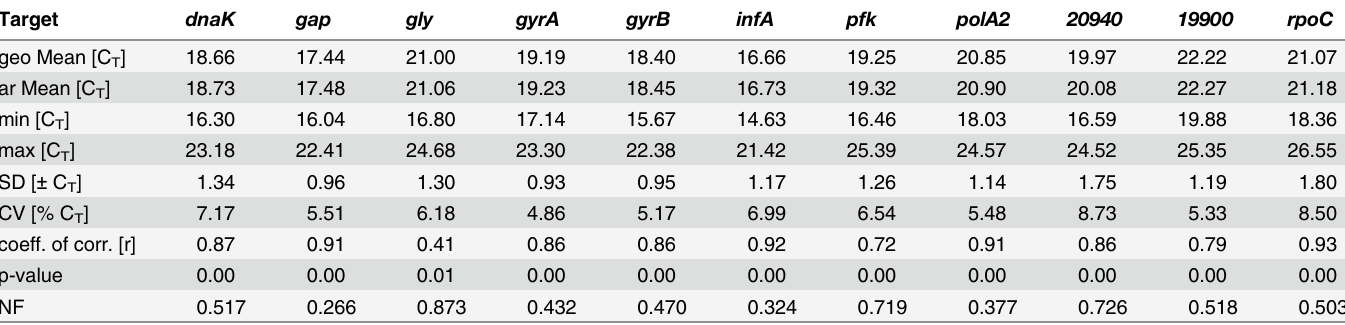
Table 6. Descriptive statistics and stability values of candidate reference genes across all conditions and time points ( n = 45). Target